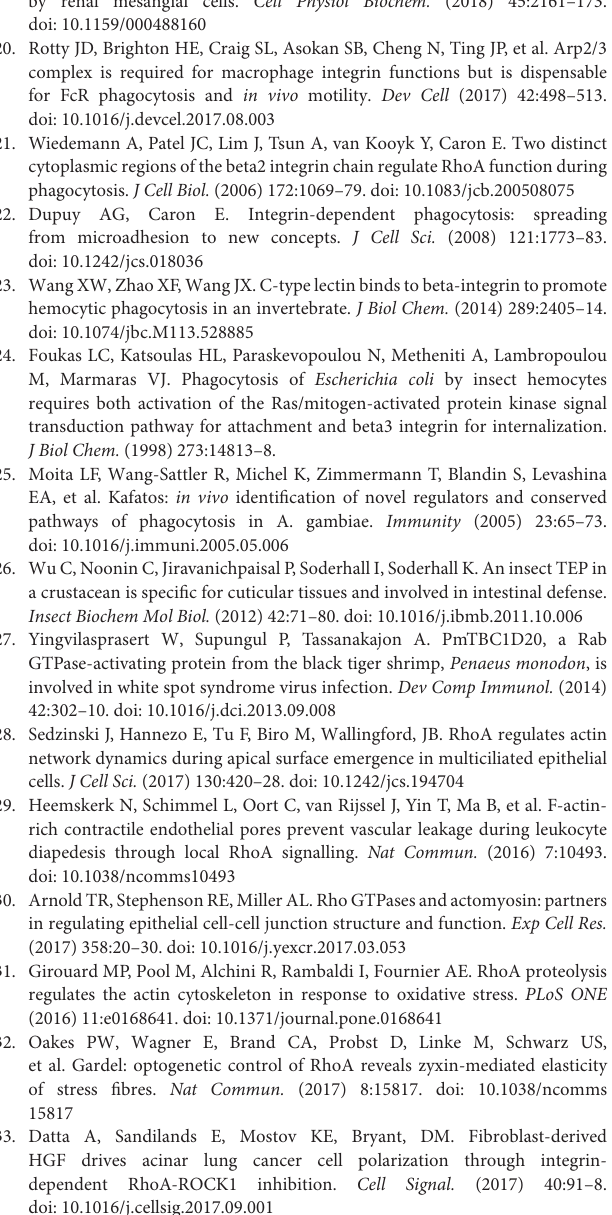
Figure S1 | The full-length nucleotide sequence of MjRhoA cDNA and predicted amino acid sequence of Mj RhoA. Figure S2 | Multiple sequence alignment and phylogenetic tree of MjRhoA . (A) Multiple sequence alignment of MjRhoA with RhoAs of 19 other species: Acanthaster planci, Callorhinchus milii, Ciona intestinalis, Danaus plexippus, Danio rerio, Drosophila melanogaste, Felis catus, Gallus gallus, Homo sapiens, Meleagris gallopavo, Mus musculus, Myotis lucifugus, Ovis aries, Papilio xuthus, Poeciliopsis prolifica, Strongylocentrotus intermedius, Sus scrofa, Tigriopus japonicus, Xenopus laevis . (B) Phylogenetic tree of MjRhoA with RhoA amino acid sequences of 19 other